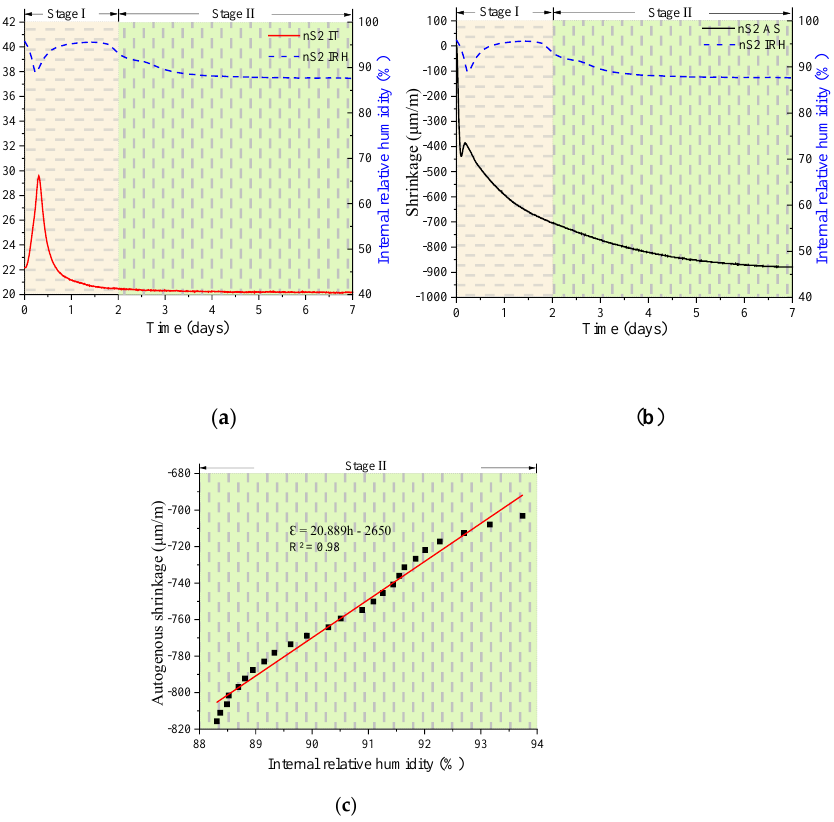
Figure 6. Development of the IRH and IT ( a ) and autogenous shrinkage ( b ) with the age of the nS2 specimen. Linear regression results ( c ) of the IRT and autogenous shrinkage of the nS2 specimen in stage II.